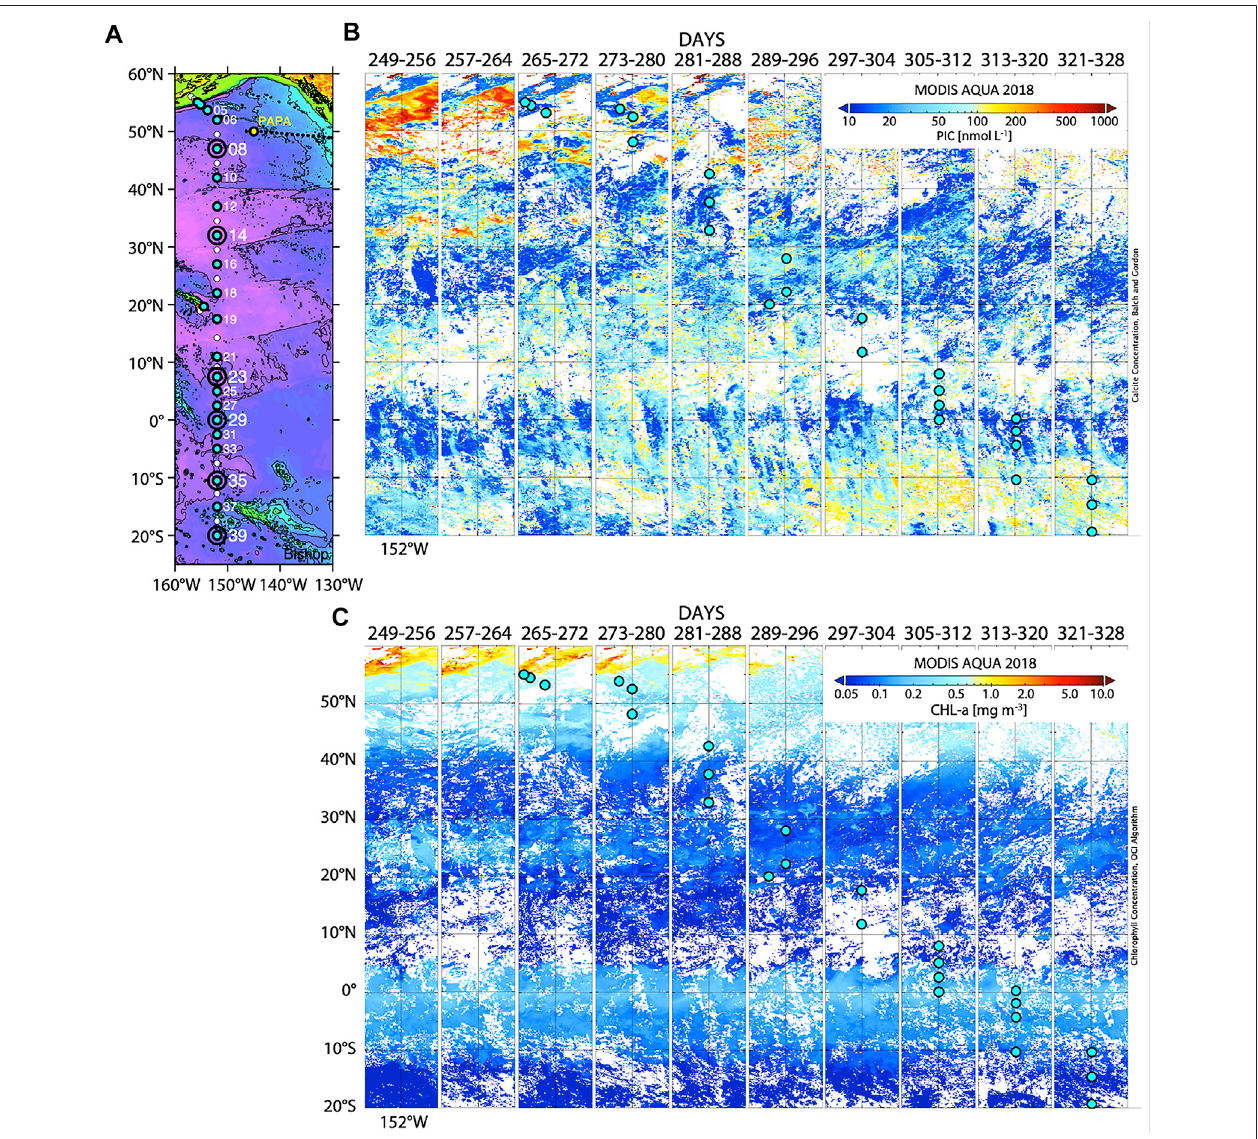
FIGURE2| SpatialandremotesensingcontextfortheSeptembertoNovember2018GEOTRACESGP15transect fromAdak AlaskatoTahiti. Stationswherethe McLane large volume in situ fi ltration system was deployed are denoted by cyan- fi lled symbols. Stations ringed with a large circle denote locations with three casts (A) . TheGEOTRACESTraceElementCarousel(GTCCTD)wasdeployedatallstations. (B) showsMODISAQUAsatelliteretrievalsofPICaveragedover8 daysfrom60 ° Nto 20 ° S and from 147 ° W to 157 ° W at 4 km resolution over the time of the transect. The UTC day range for each swath is shown at the top of each swath. Station locations are mapped onto the contemporaneous swath. (C) shows similar swaths for MODIS AQUA chlorophyll. Plots were made using Panoply, an application of the NASA Goddard Institute for Space Studies.